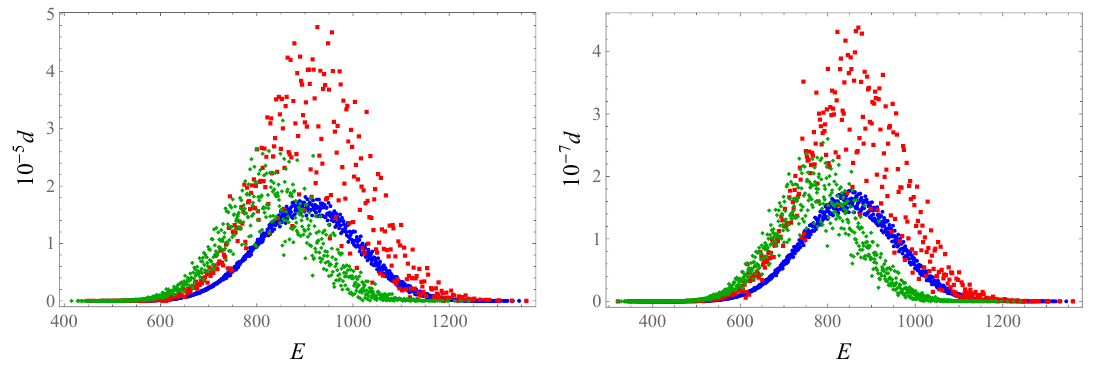
Figure 3 . Plot of the degeneracy d versus the energy E for the spectra of the A N (cid:0) 1 HS chain (2.3) with J = 2 (red squares), the D N HS chain (2.8) with J = 1 = 2 (green rhombuses) and the model (2.1) (blue circles) for N = 16 spins and m = 3 (left) or m = 4 (right).